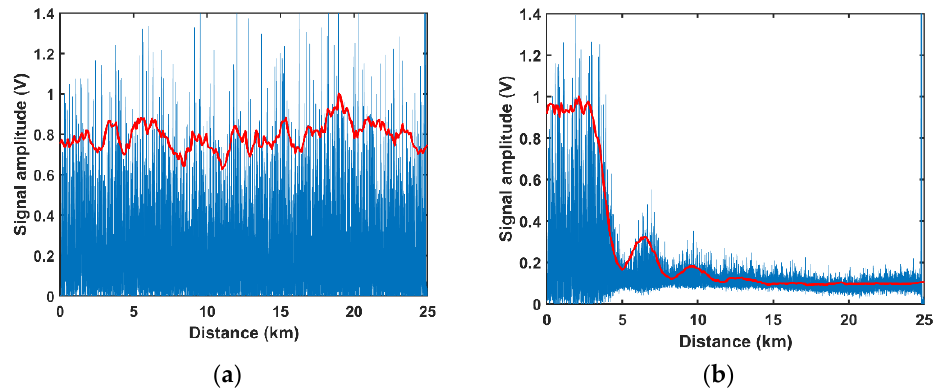
Figure 3. The normalized Rayleigh trace (blue line) and its normalized amplitude (red line) along the FUT when the input power is: ( a ) 150 mW; ( b ) 1240 mW.